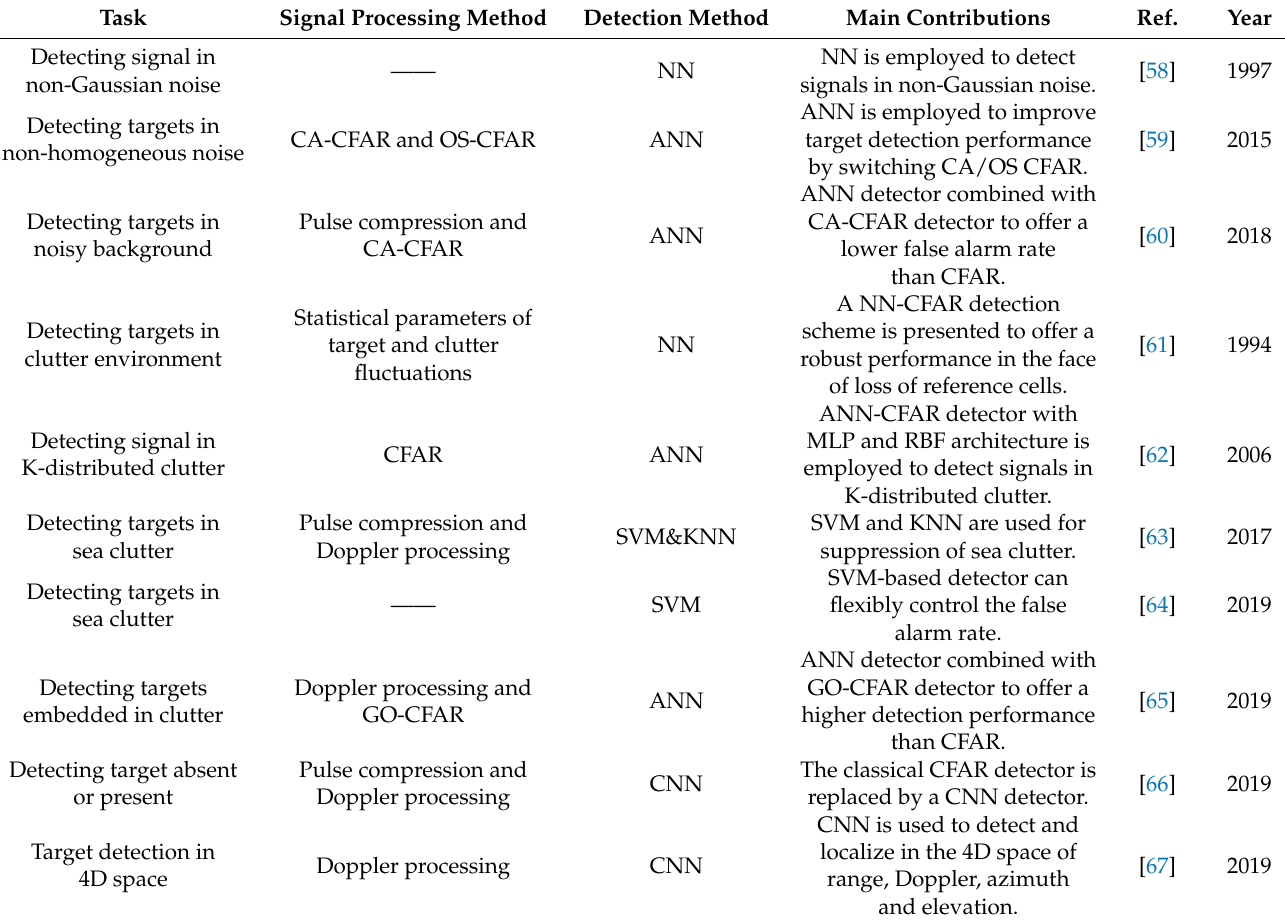
Table 1. Summary of RTD tasks and methods in recent